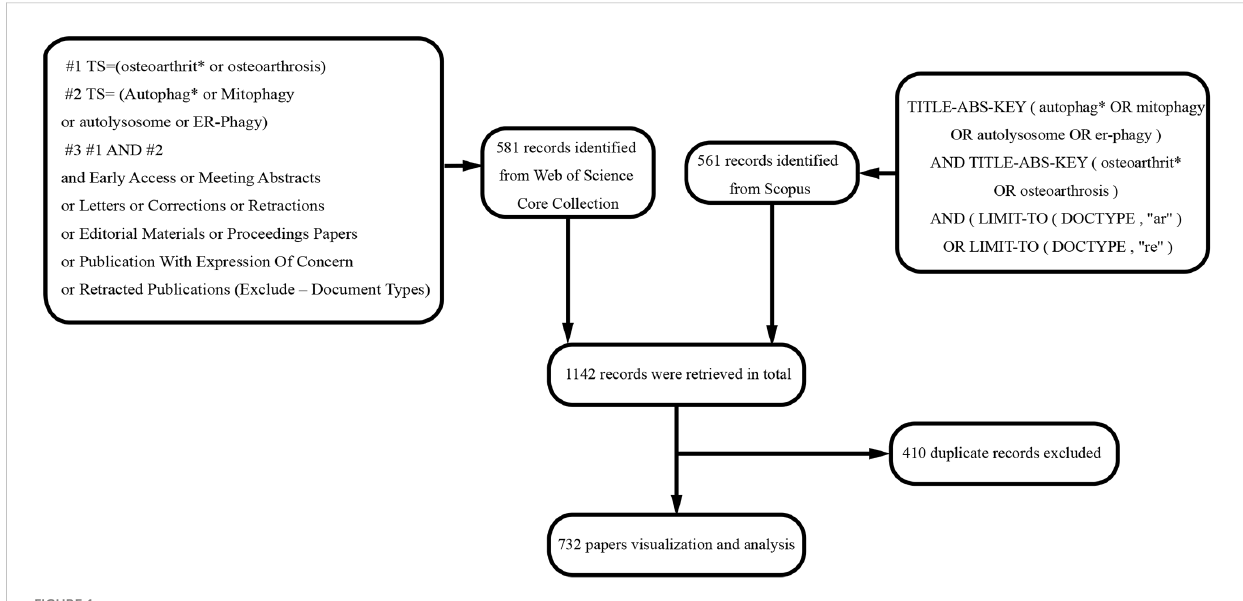
FIGURE 1 Flowchart of literature search and